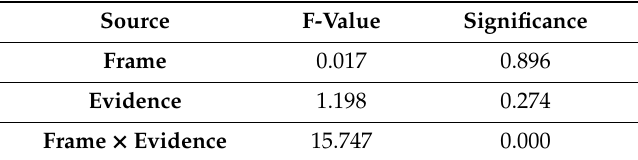
Table 9. Results of ANOVA (frame and message